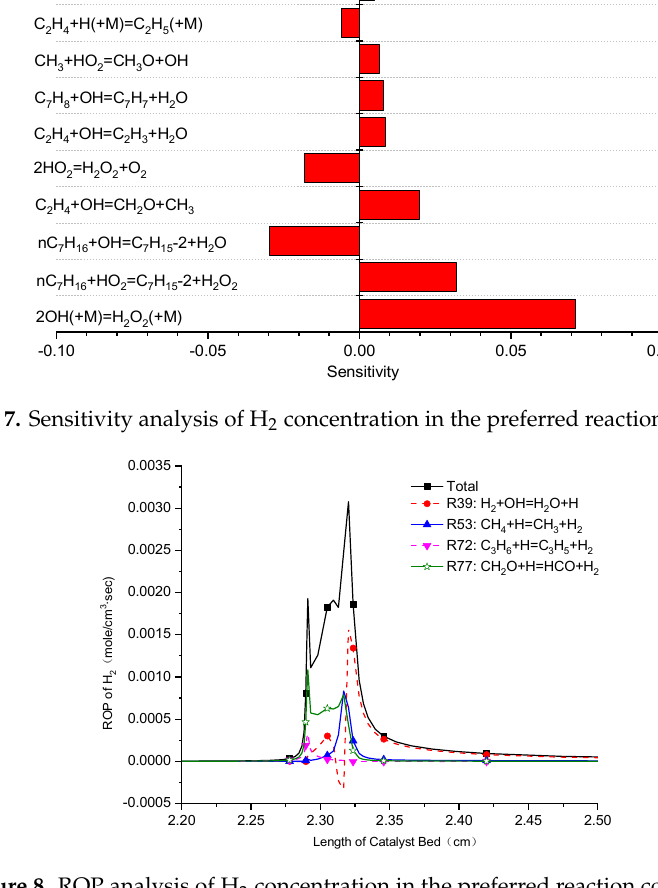
Figure 8. ROP analysis of H 2 concentration in the preferred reaction conditions.